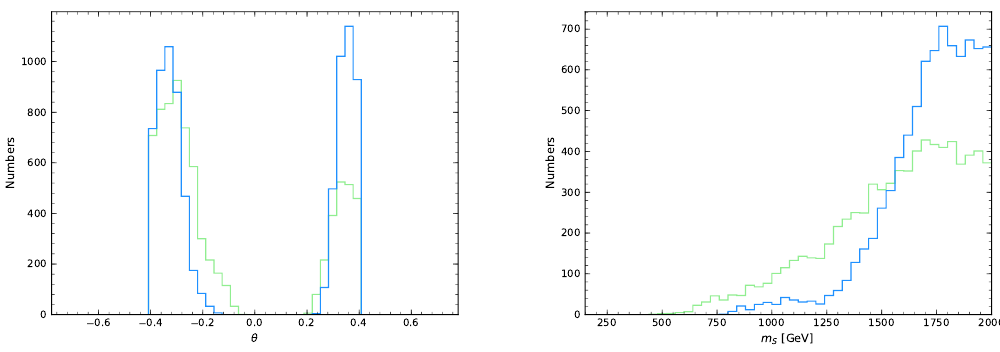
Figure 14 . Same as the lower two plots in (cid:12)gure 13 after taking into account the experimental